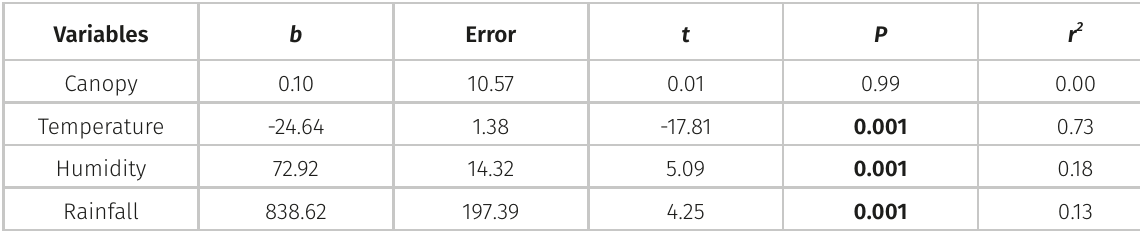
Table V. Influence of environmental variables on the assemblage of Hymenochaetales and Polyporales near the Silvio Braga HPP, in Santarém, PA. b = slope of the line, Error = Standard Error, t = critical t value, P = p value, r 2 = adjusted r value. Values in bold, significant at ≤